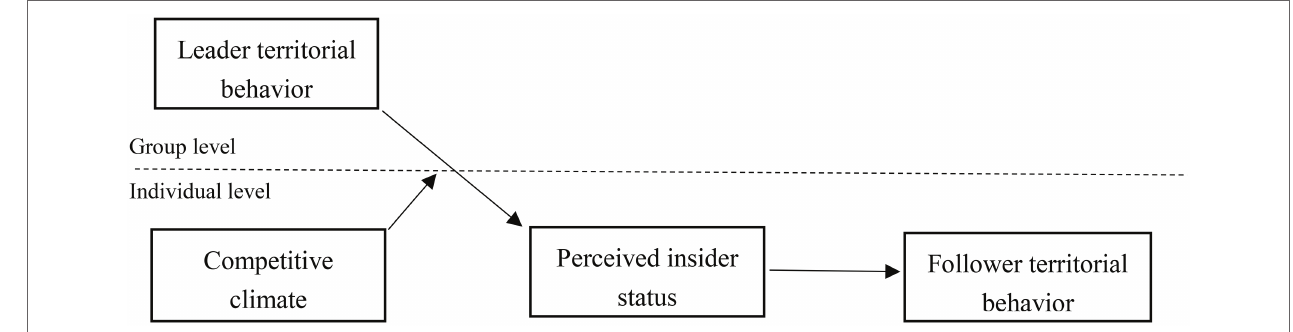
FIGURE 1 | Theoretical